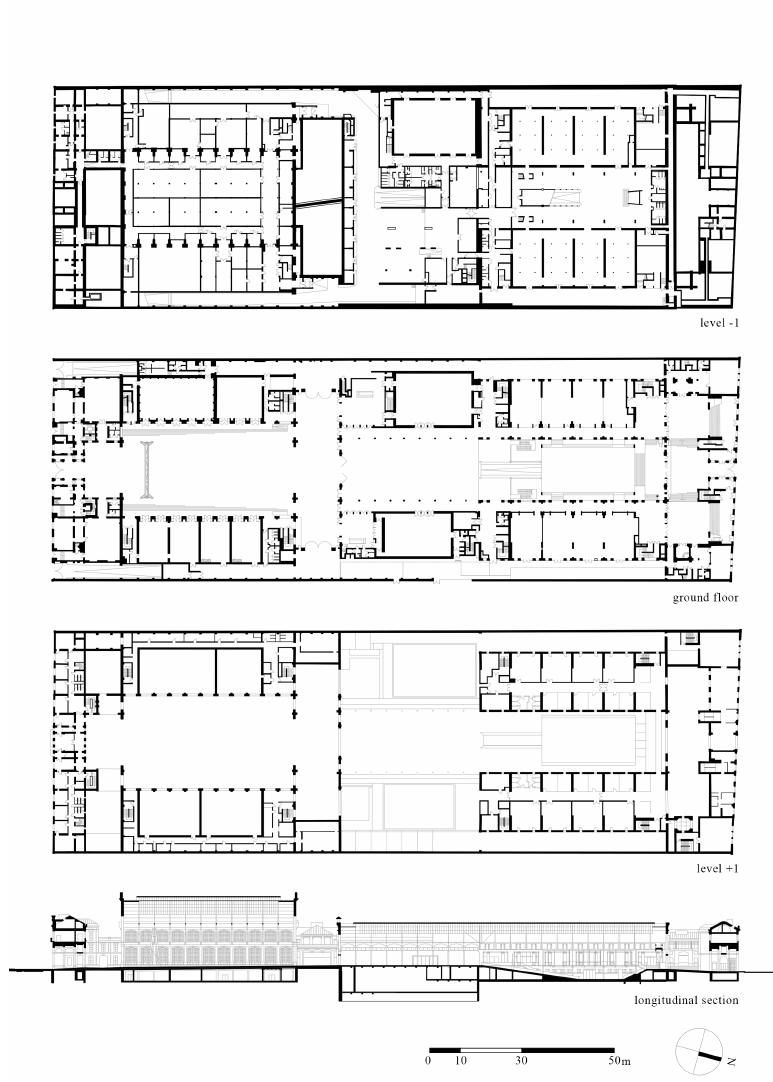
Figure 2. Plans and longitudinal section of the Paris Centquatre